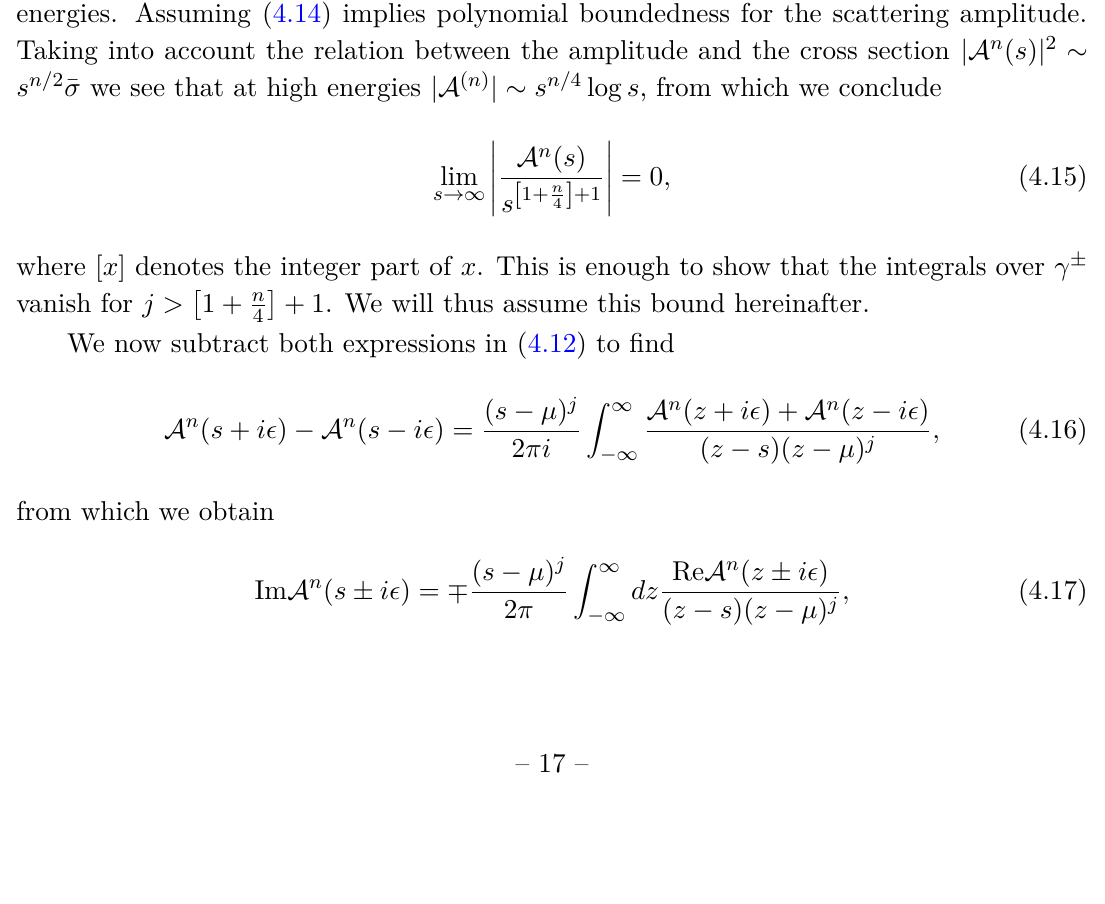
in the corresponding half of the complex plane is s is | s | → ∞ ∞